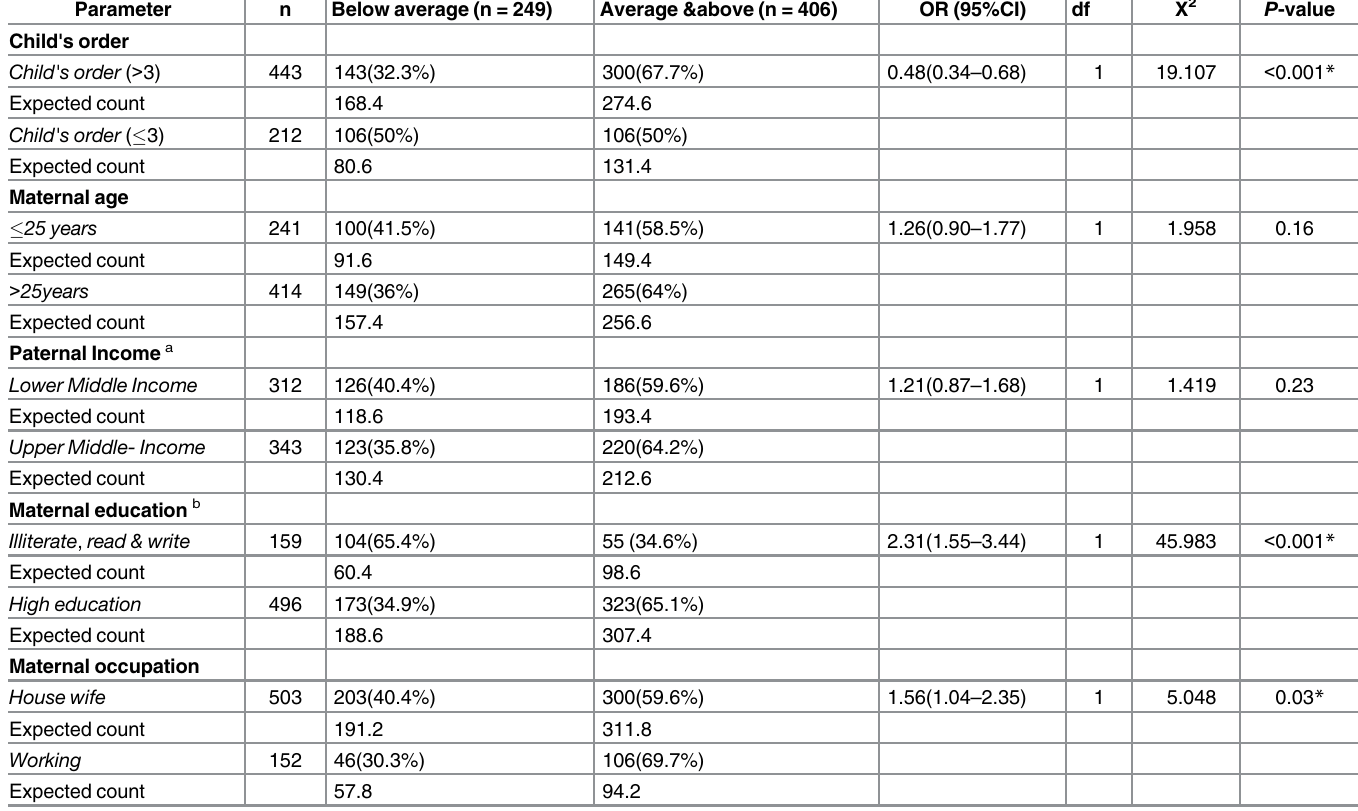
Table 2. Association of socioeconomic variables with socio-emotional composite scores categories in a group of 655 Egyptian infants and chil- dren aged 6 – 24 months